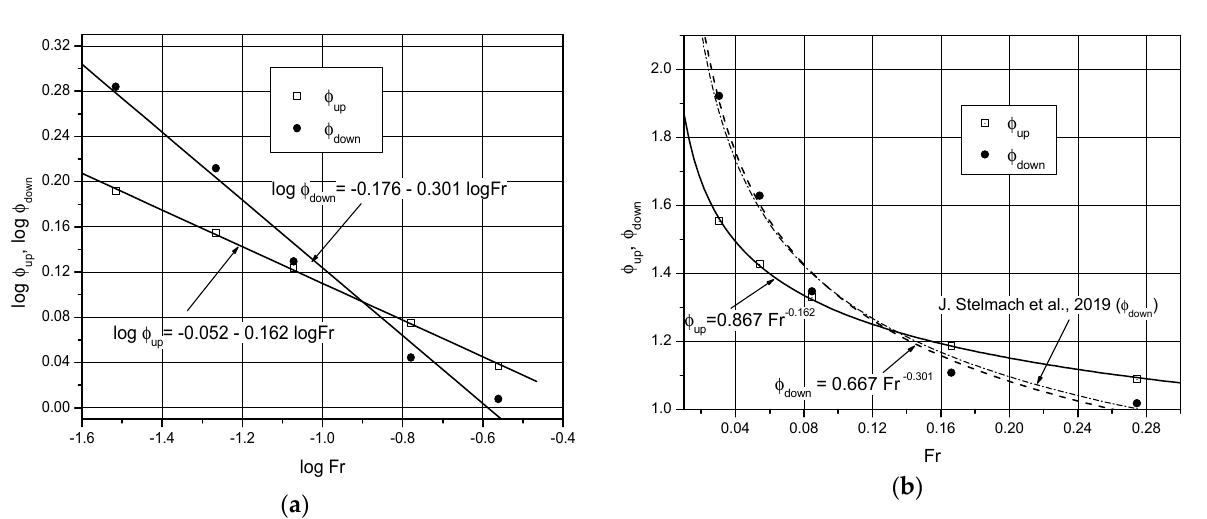
Figure 8. Changes in the coefficients of increasing the mixing power during emptying the tank. ( a ). log-logsystem, ( b ). normal system.